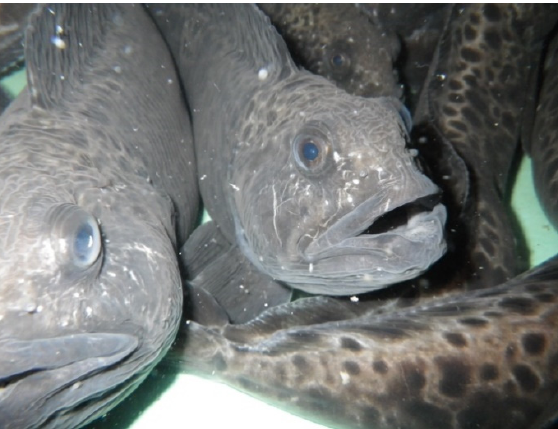
Figure 1. Subadults spotted wolffish in on-growing tanks at Maurice Lamontagne facilities (DFO/MPO, Mont-Joli, QC, Canada). Source: UQAR, Savoie, A. (DFO/MPO, Mont-Joli, QC, Canada). Source: UQAR, Savoie,